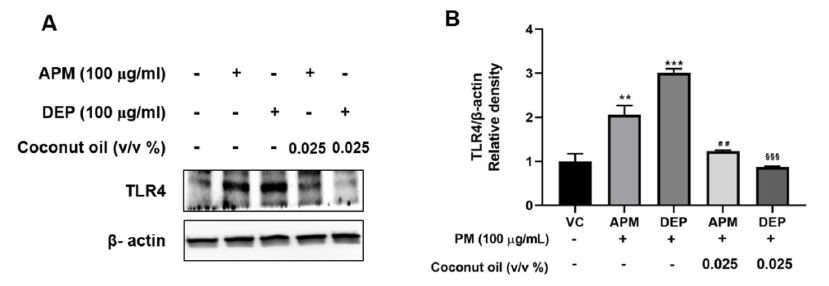
Figure 6. ( A ) Representative Western blots and ( B ) relative density of toll − like receptor (TLR) 4 ex ‐ pression in artificial particulate matter (APM) and diesel exhaust particles (DEP) − stimulated alveo ‐ lar macrophages (MH − S). Vehicle control (VC) was treated with cell medium including 10% distilled water. Data are presented as the means ± SD (n = 3 per group). ** p < 0.01 or *** p < 0.001 vs. VC; ## p < 0.01 vs. APM group; §§§ p < 0.001 vs. DEP group.